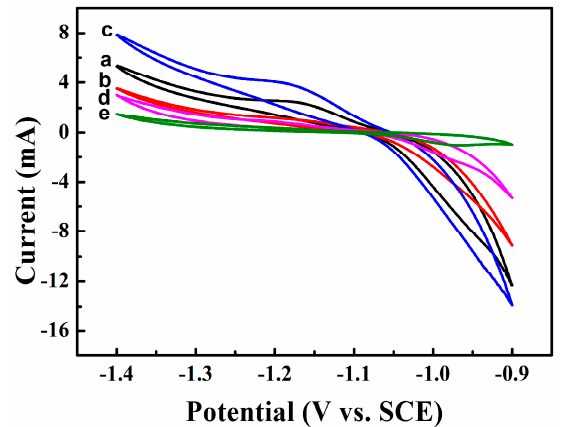
Figure 1. The CV of the zinc electrode in the aqueous electrolyte containing different monocarboxylates from − 1.4 to − 0.9 V at 50 mV ∙ s − 1 . (a: sodium formate; b: sodium acetate; c: sodium propionate; d: sodium butyrate; and e: sodium valerate).